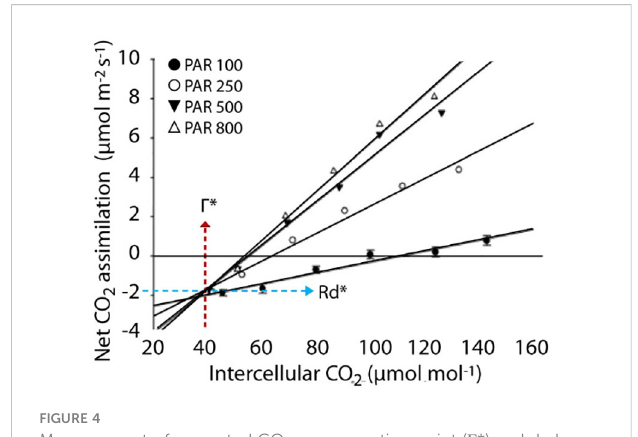
FIGURE 4 Measurement of corrected CO 2 compensation point ( Г *) and dark respiration in the light (Rd*) in rice plants following Brooks and Farquhar